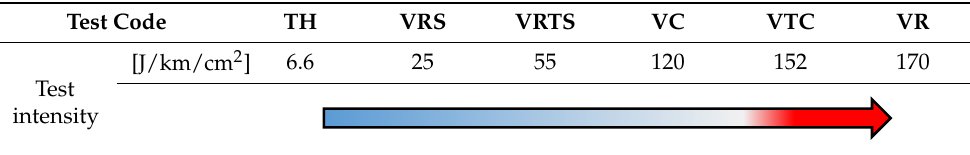
Table 4. Intensity scale of preliminary tests based on average surface activation energy per kilometer per area unit.